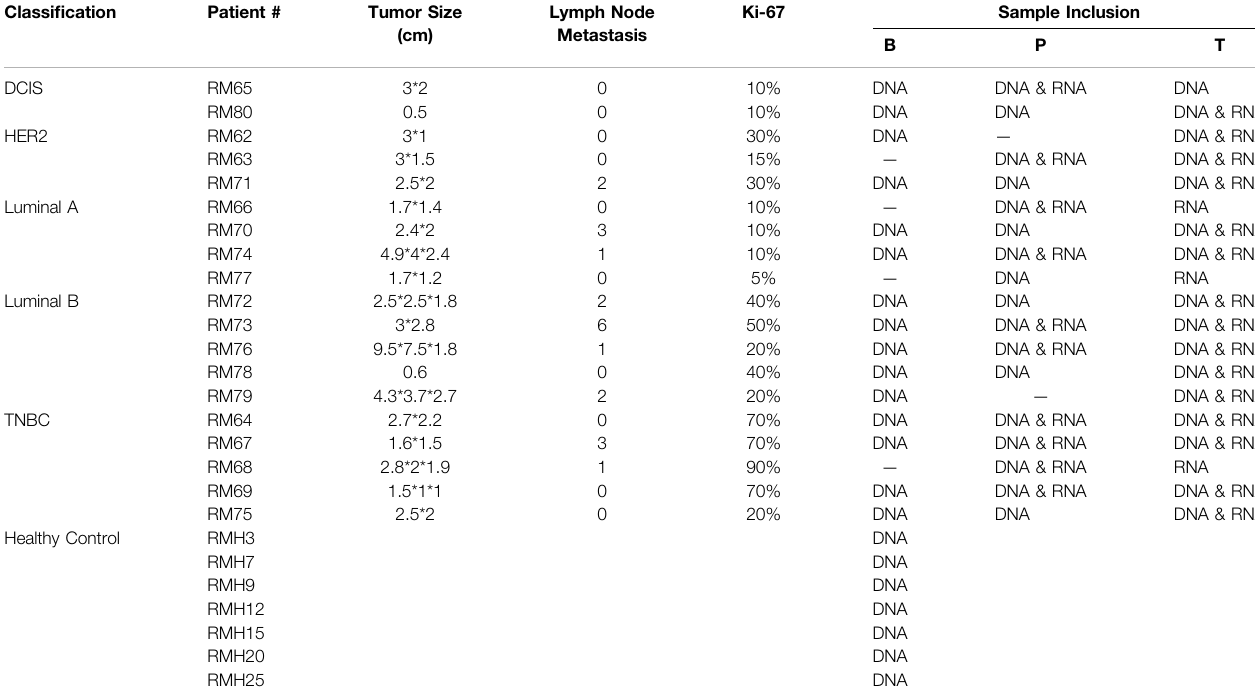
TABLE 1 | Clinicopathological features of breast cancer patients and healthy controls recruited. Classi fi cation Patient #